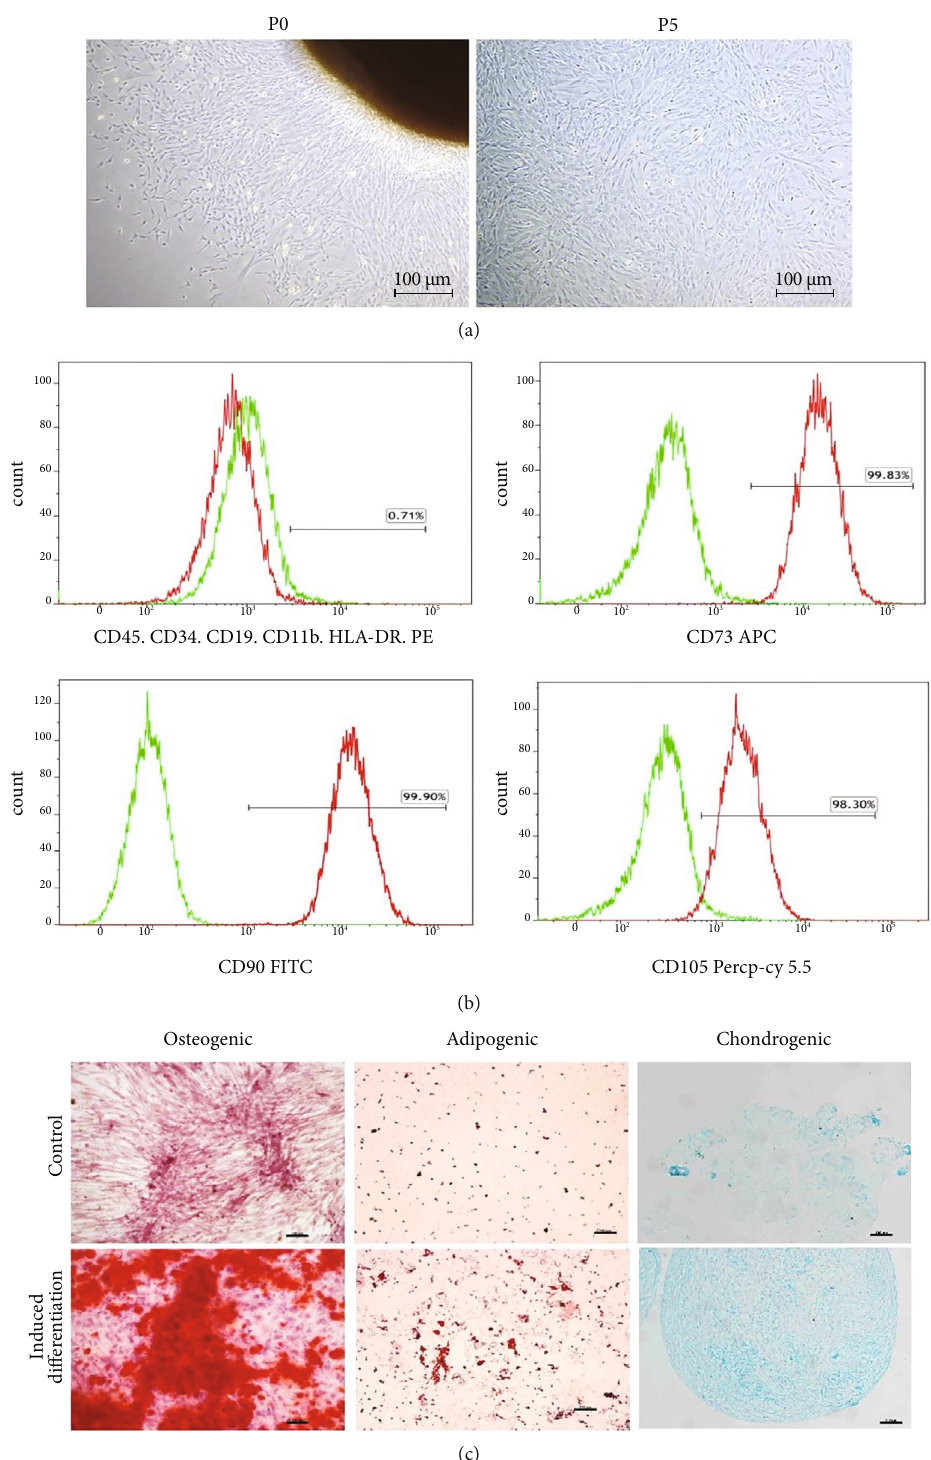
Figure 1: Isolation and identi fi cation of UCMSCs. (a) Photographs of UCMSCs at passage 0 (P0) and P5, showing spindle-shaped UCMSCs. Scale bar = 100 μ m . (b) Flow cytometry results. Green line represents isotype control, and red line represents UCMSCs. UCMSCs with positive CD73, CD90, and CD105 expression and negative CD45, CD34, CD19, CD11b, and HLA-DR expression. (c) Alizarin Red S, Oil Red O, and Alcian Blue staining. Results showed that UCMSCs di ff erentiated into osteocytes, adipocytes, and chondrocytes. Scale bar = 100 μ m